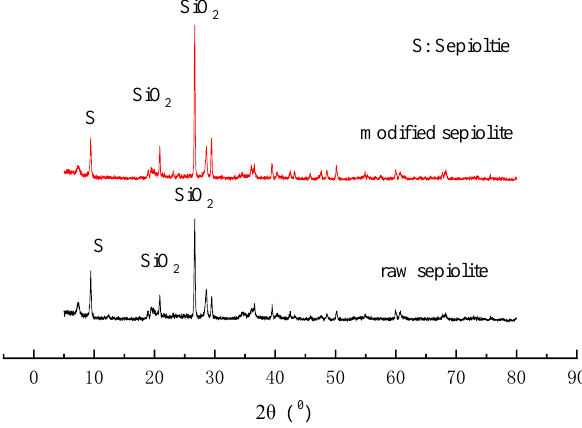
Figure 2. X-ray diffraction spectra of original sepiolite and modified sepiolite. Figure 2. X-ray di ff raction spectra of original sepiolite and modified